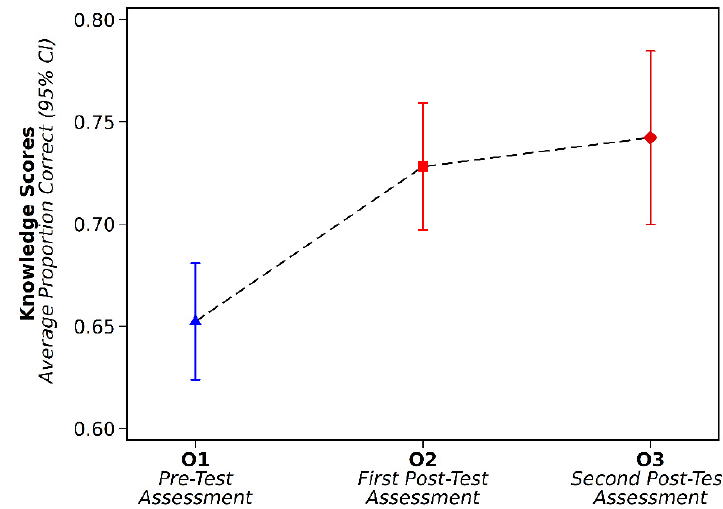
Figure 1. Change in Knowledge Scores.